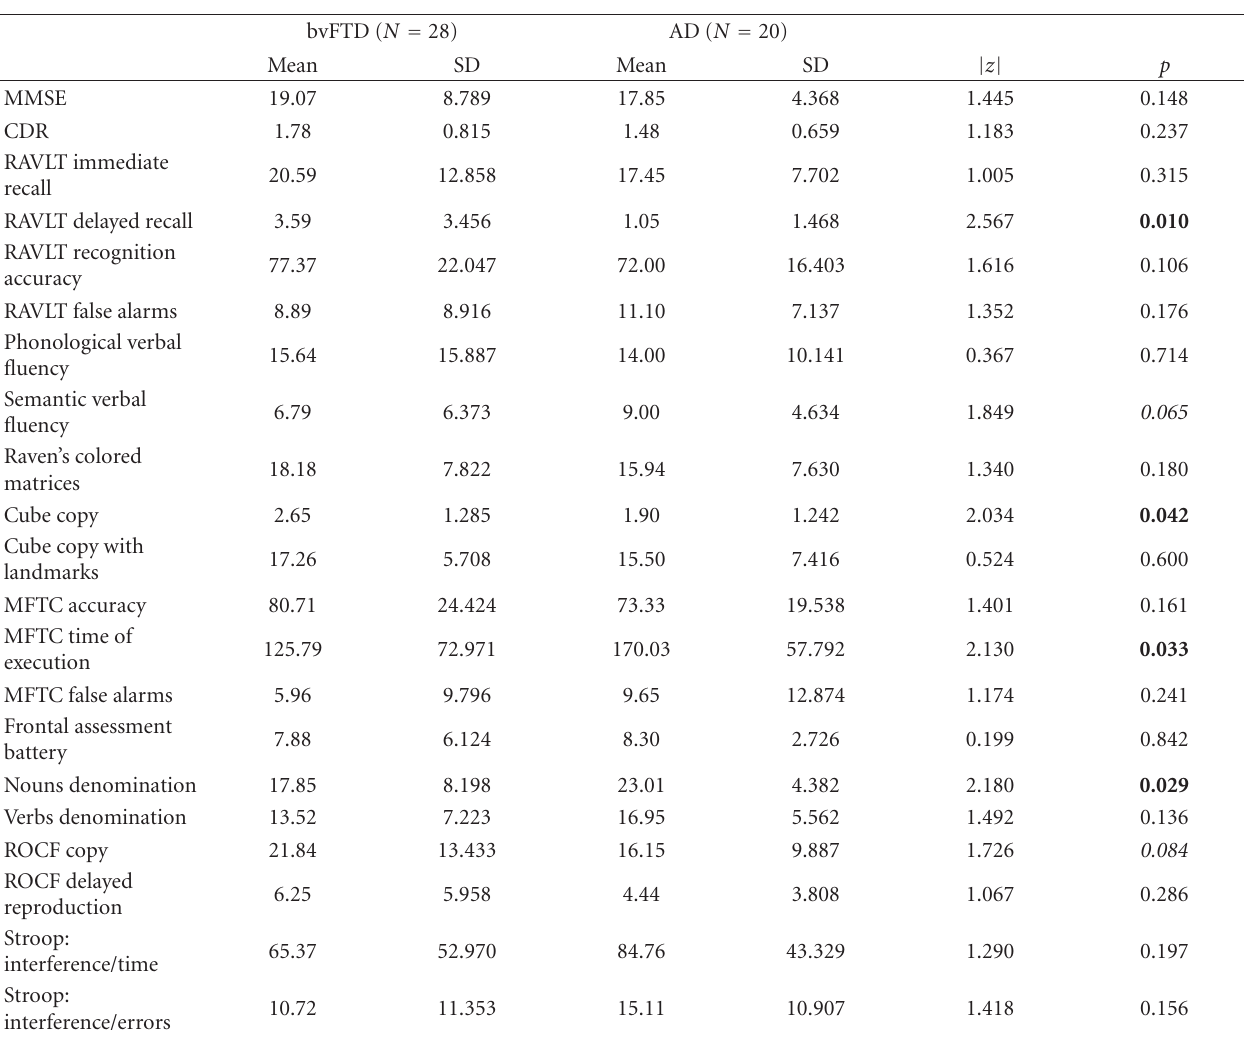
Table 1: Comparison of neuropsychological performances of the two groups. Statistically significant di ff erences are indicated in bold; confounders included in the logistic regression analysis are reported in italics. MMSE: Mini-Mental Sate examination; CDR: Clinical Complex